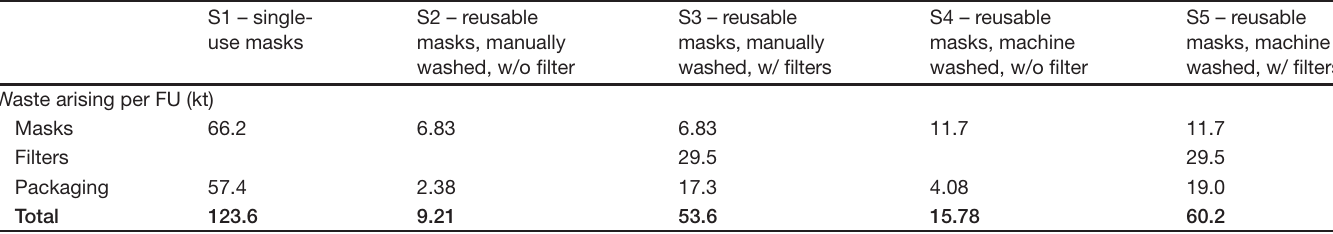
Table A10. Waste arising (thousand tonnes per FU) due to face mask use in the UK for 1 year. S1 – single- use